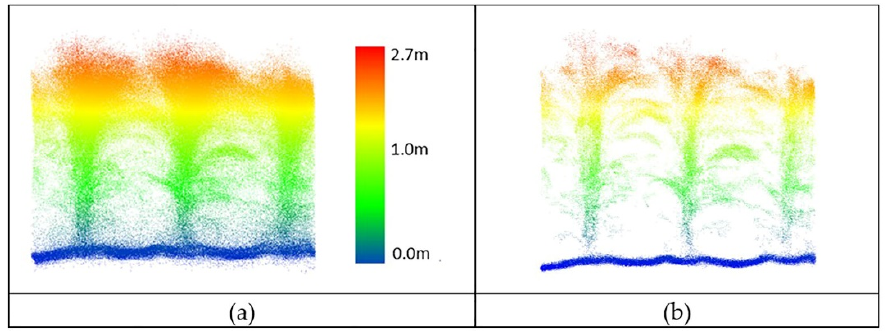
Figure 20. PhenoRover LiDAR data of maize (DAS:62). ( a ) Original data, ( b ) outlier removal using PointCleanNet.